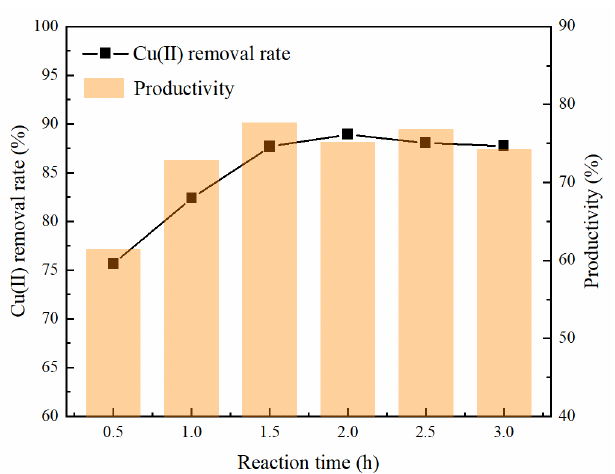
Figure 6. Effect of reaction time on the productivity of MF@AA and Cu(II) removal efficiency.